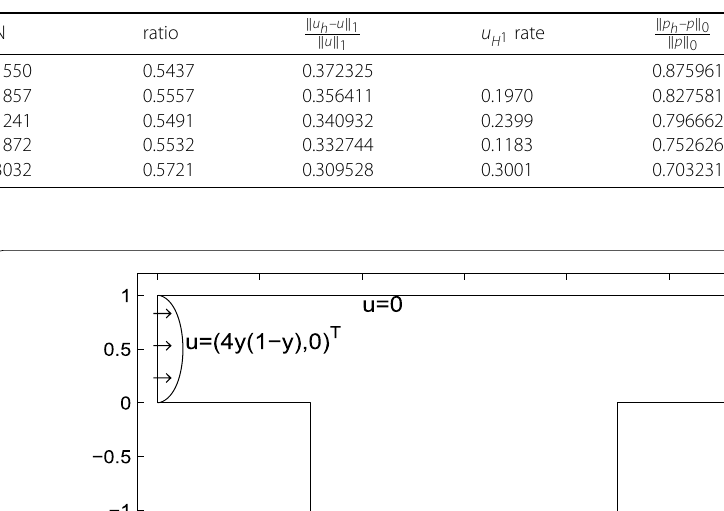
Table 2 Error and the effective index on uniform meshes with ν = 1